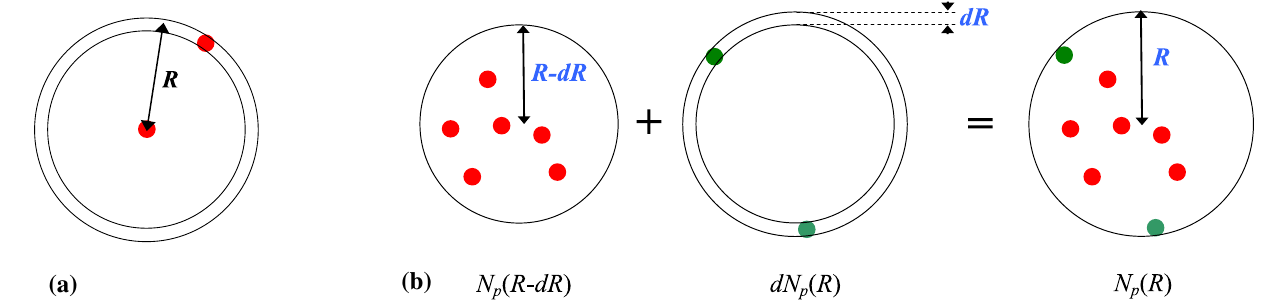
to analyse our data set, they are not positioned at a fixed location, but instead they have collected all the points that fall within the domain they define. To count the pairs within the disk R we can count the pairs of disk R − dR and add the pairs within the ring with radii R − dR and